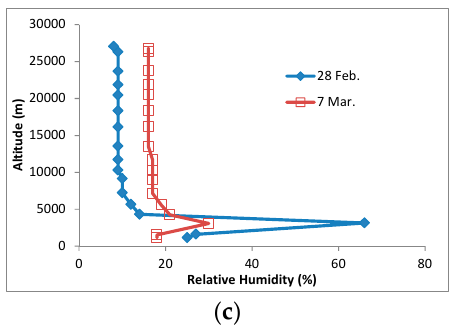
Figure 10. Vertical profiles of ( a ) pressure, ( b ) temperature, and ( c ) relative humidity measured using radiosondes released on 7 March and 28 February 2017. To acquire the diffuse-to-global irradiance ratio data, an irradiance sphere was used with a SVC GER1500 spectrograph at the calibration site to measure the irradiance at ten minutes intervals throughout the day. Each of the measurements outlined below were repeated three consecutive times. The global solar irradiance (L1) was measured fist, followed by the sky diffuse irradiance (L2), which was assessed with a light barrier. Finally, the global solar irradiance (L3) was determined [20]. Figure 11a shows the diffuse-to-global irradiance ratios at 550 nm on the date of the SPARK satellite overpass during the Dunhuang experiment. The smooth diffuse-to-global irradiance ratio curve indicates a very stable atmosphere on 7 March 2017. Figure 11b shows diffuse-to-global irradiance ratio for the entire spectrum at the time of the SPARK satellite overpass; the lower aerosol burden on 7 March 2017 caused lower diffuse-to-global irradiance ratios in comparison to those measured on 28 February 2017. Lastly, the diffuse-to-global irradiance ratios were convolved with the spectral response functions of the corresponding SPARK satellites channels.